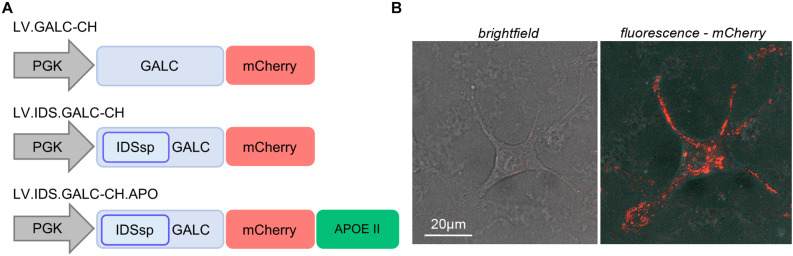
Lentiviral vectors driving the expression of chimeric GALC constructs. (A) Schematic of LVs encoding for murine GALC.mCherry (GALC-CH) and GALC-CH-derived chimeric constructs (IDS.GALC-CH and IDS.GALC-CH.APO). (B) Representative confocal live imaging picture showing mCherry direct fluorescence in LV.GALC-CH-transduced WT NPCs (brightfield and fluorescent channel). 63× magnification and zoom (∼2×). Scale bar, 20 μm (see also Supplementary Video 1).